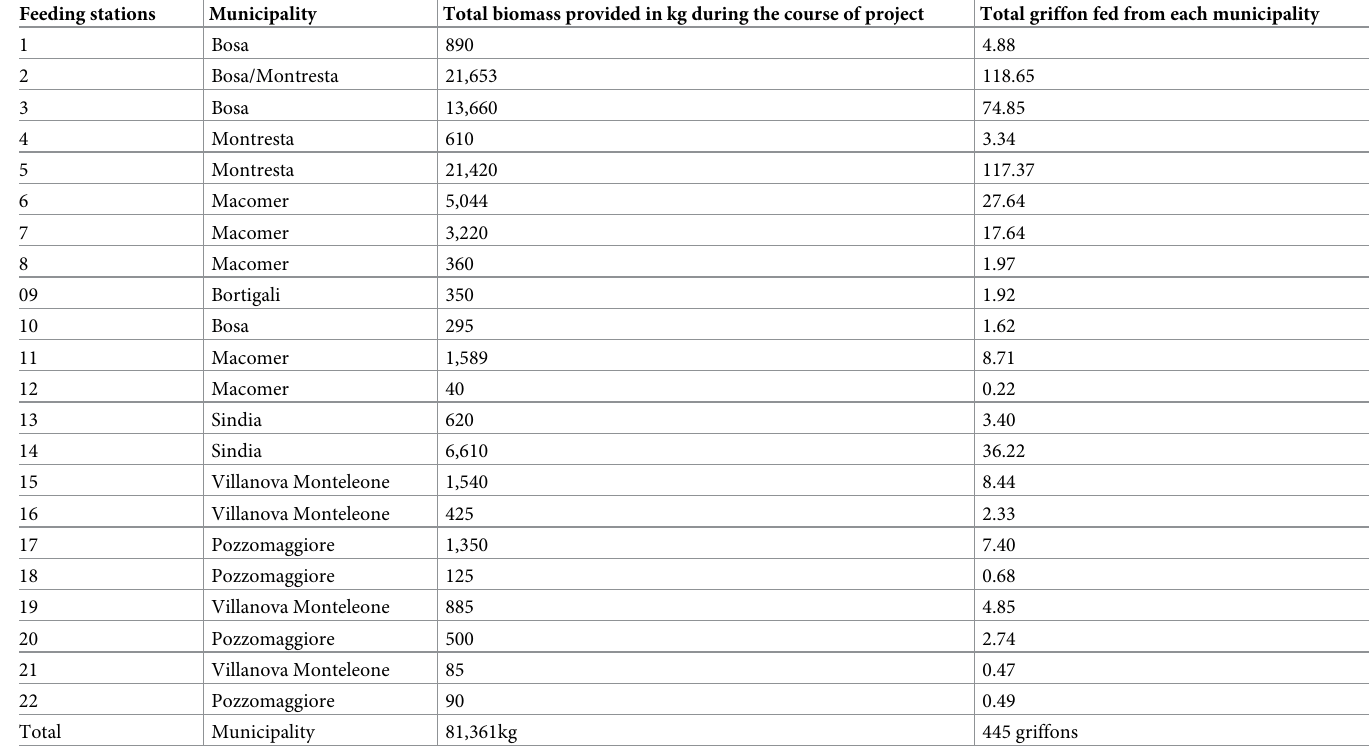
Table 1. Carrion biomass in kg delivered from farms in each municipality and total number griffons fed with in the conservation project. Feeding